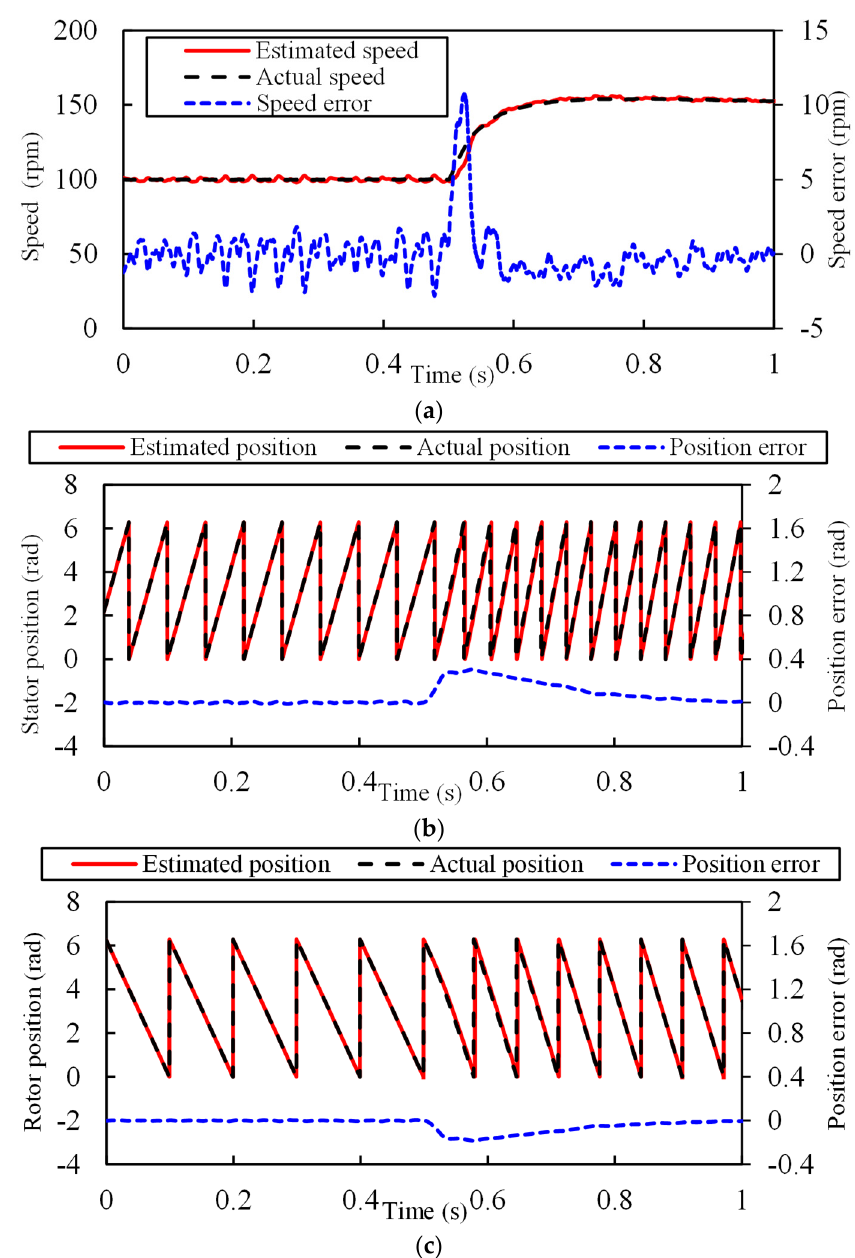
Figure 14. The speed step results of estimating from the opposite side. ( a ) Speed. ( b ) Stator position. ( c ) Rotor position.